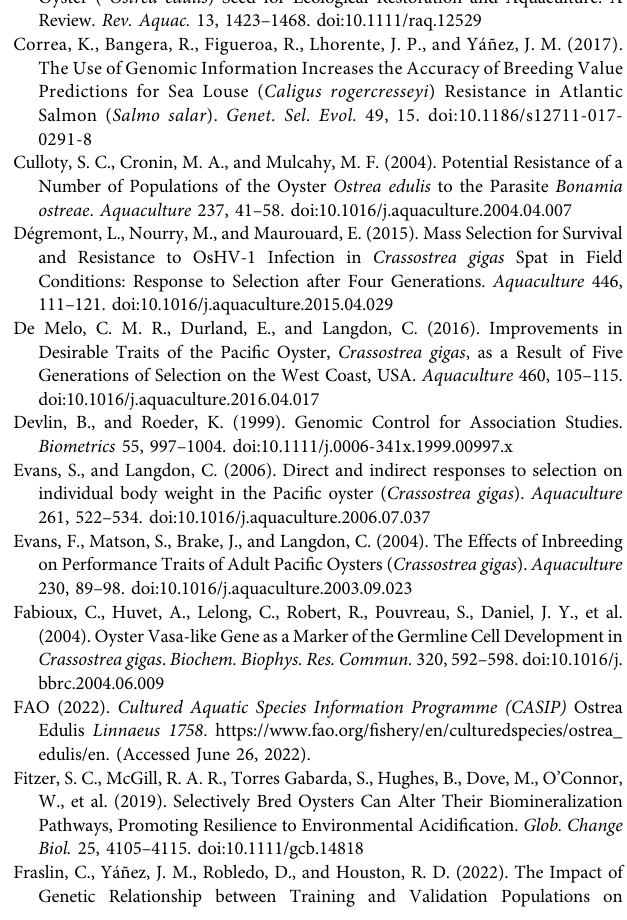
Supplementary Figure S1 | PCA of the O.edulis population under study showing the dominance of single cluster comprised of highly related individuals (clst_0). Supplementary Figure S2 | Quantile-quantile (Q-Q) plots showing the distribution ofthe expected (red dashed line) versusobserved P-values ofthe GWAS ofgrowth- related traits. Supplementary Figure S3 | Example of the pairwise kinship coef fi cient between individuals in the training and validation set across randomly selected iterations of different5-foldcrossvalidation(CV)replicates(tenreplicatesintotal).Boxplotsshow the distribution of values for pairs of individuals (one from the training set and one from the validation set) belonging to the same or different population clusters. Relatednesswasinferred using the KING-robustmethodimplemented in Plink